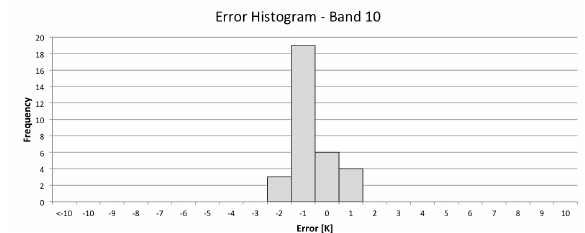
Figure 9: Histogram of error values for small subset of cloud free Landsat 8 scenes processed using band 10.